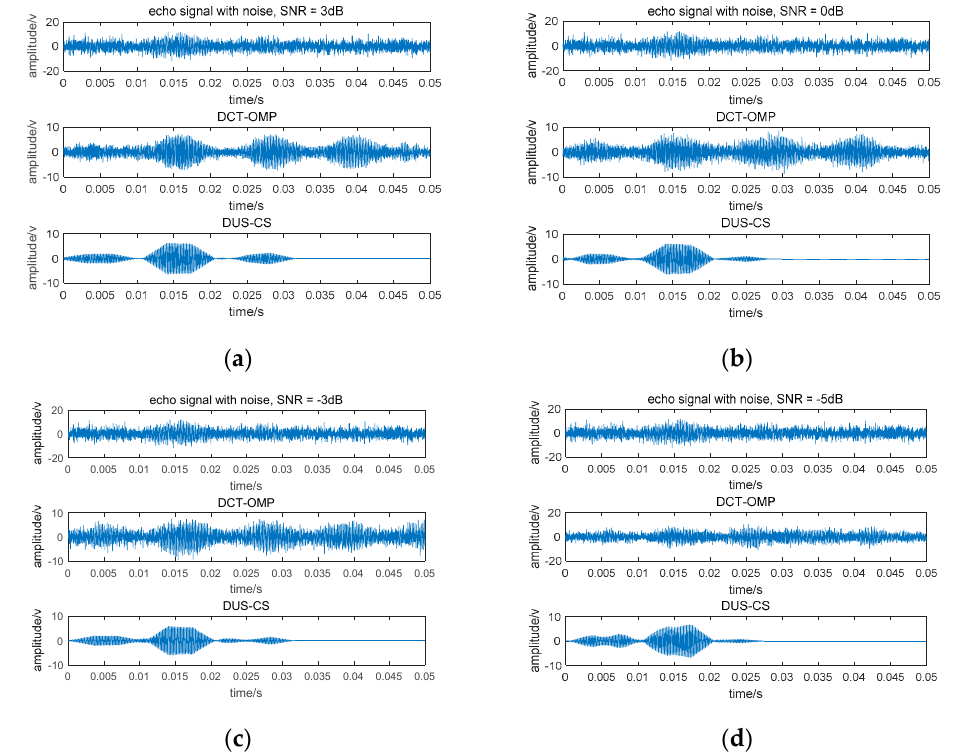
Figure 4. Reconstruction signal at a compression ratio of 50%. ( a ) SNR = 3 dB; ( b ) SNR = 0 dB; ( c ) SNR = − 3 dB; ( d ) SNR = − 8 dB.